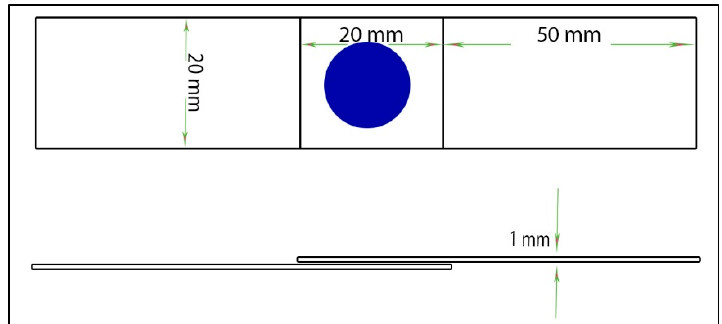
Figure 1. Schematic of tensile shear test of samples.